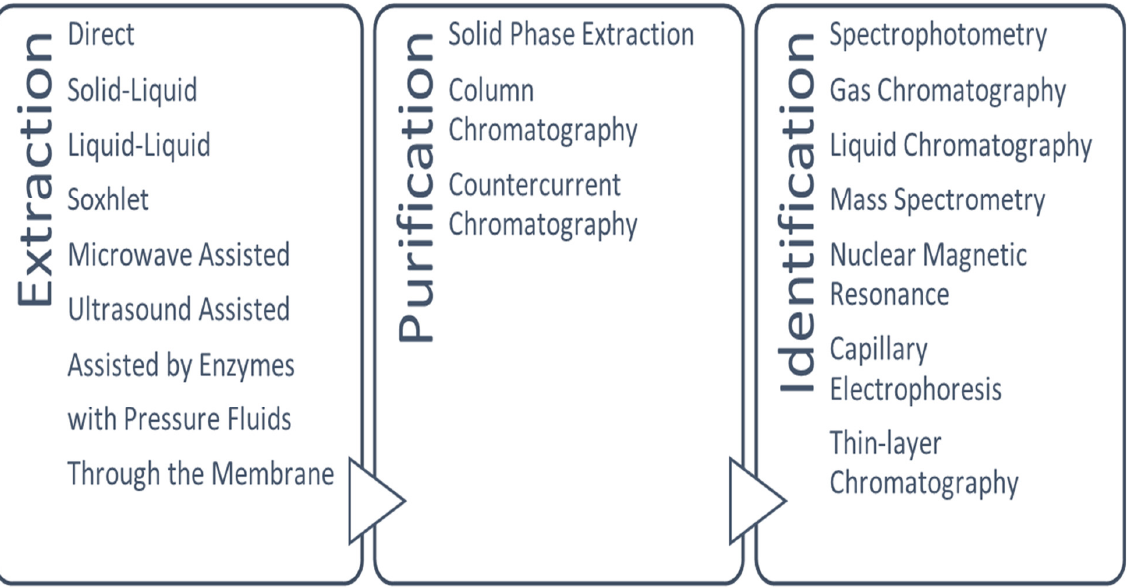
Figure 1. Techniques used in the characterization of anthocyanin compounds [25,26] .